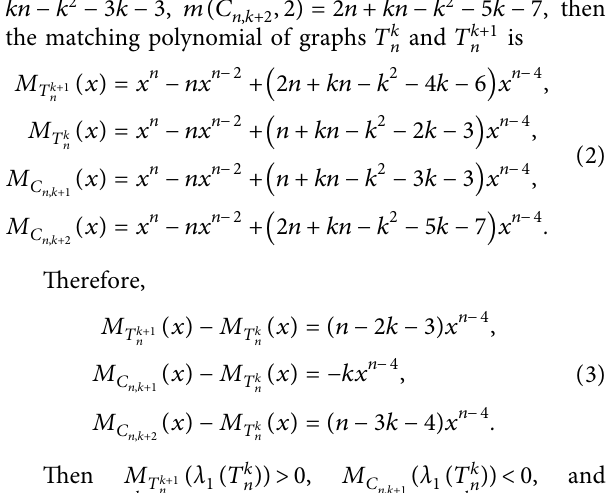
Figure 2. All the connected unicyclic graphs with matching Figure 4.